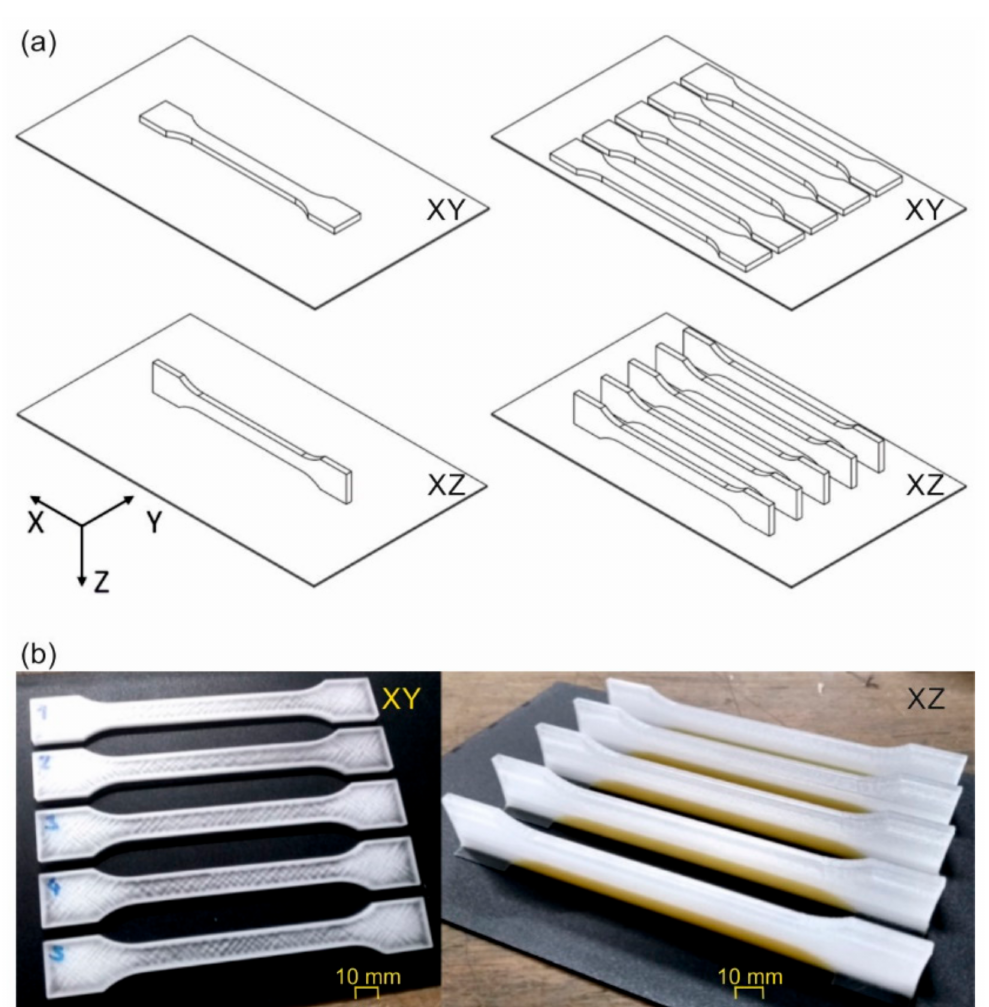
Figure 3. ( a ) Schematic representation of di ff erent orientations (XY or XZ) and arrangements (single or multiple) of tensile bars during printing, and ( b ) examples of printed parts without support material and with support material (yellowish